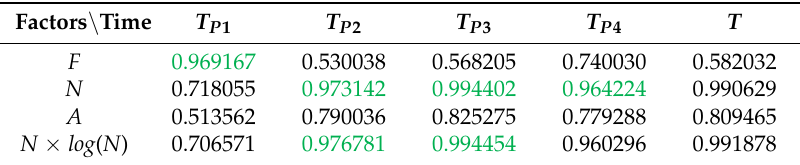
Table 3. Comparison of PCC values from different factors (The green items indicated higher correlations).